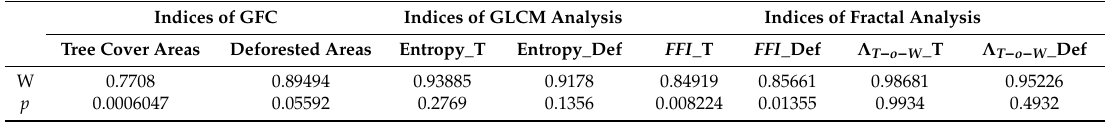
Table 3. Shapiro-Wilk test for the validation of data.